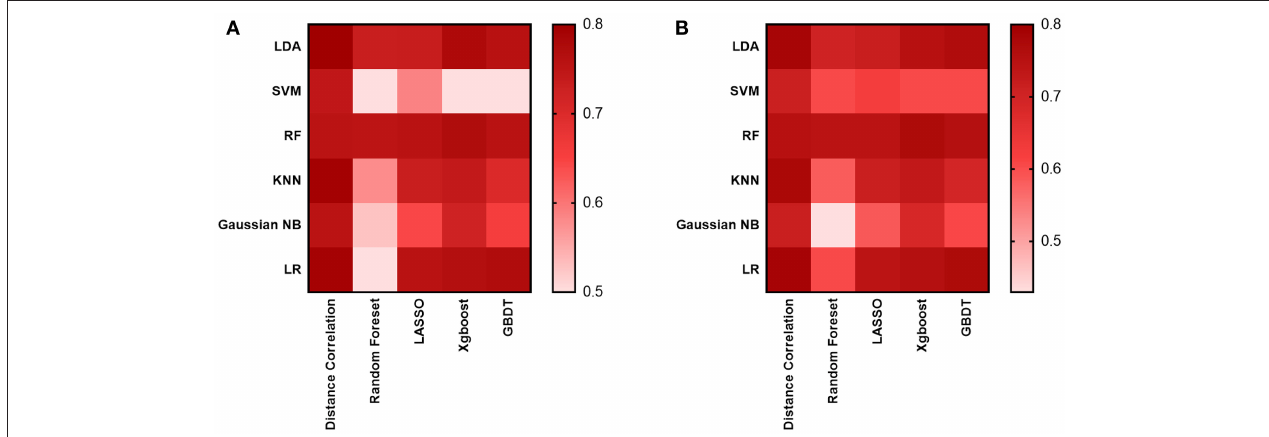
FIGURE 3 | Heat map of the classifiers for differentiating between GBM and MBTs. (A) The AUC of the training group. (B) The AUC of the testing group.